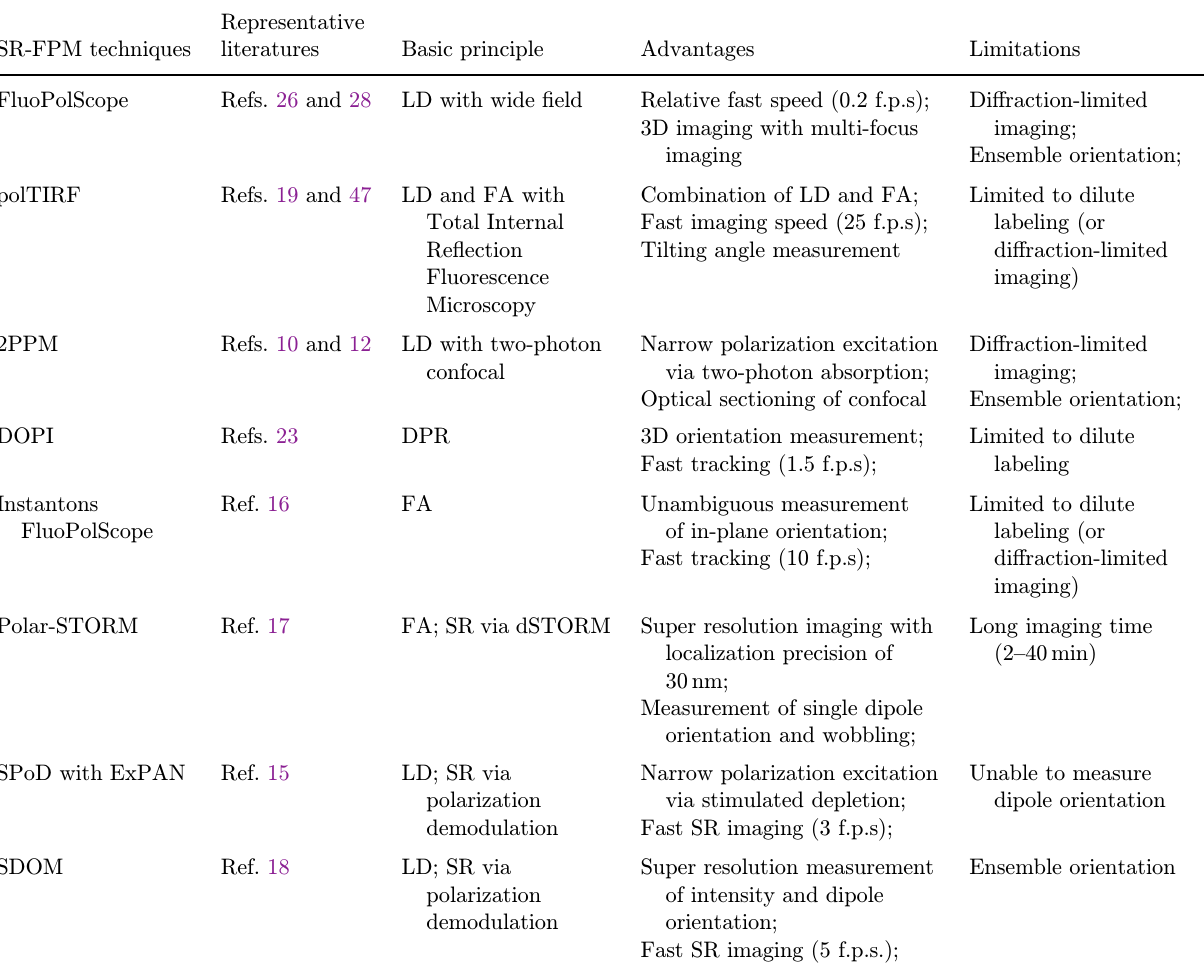
Table 1. Comparison between selective °uorescence polarization microscopy